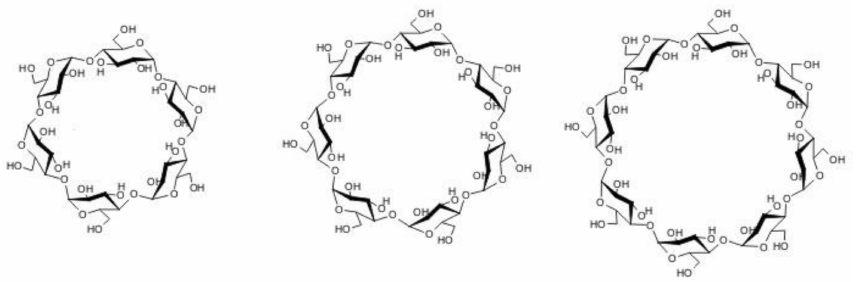
Figure 3. α -, β -, and γ -cyclodextrins’